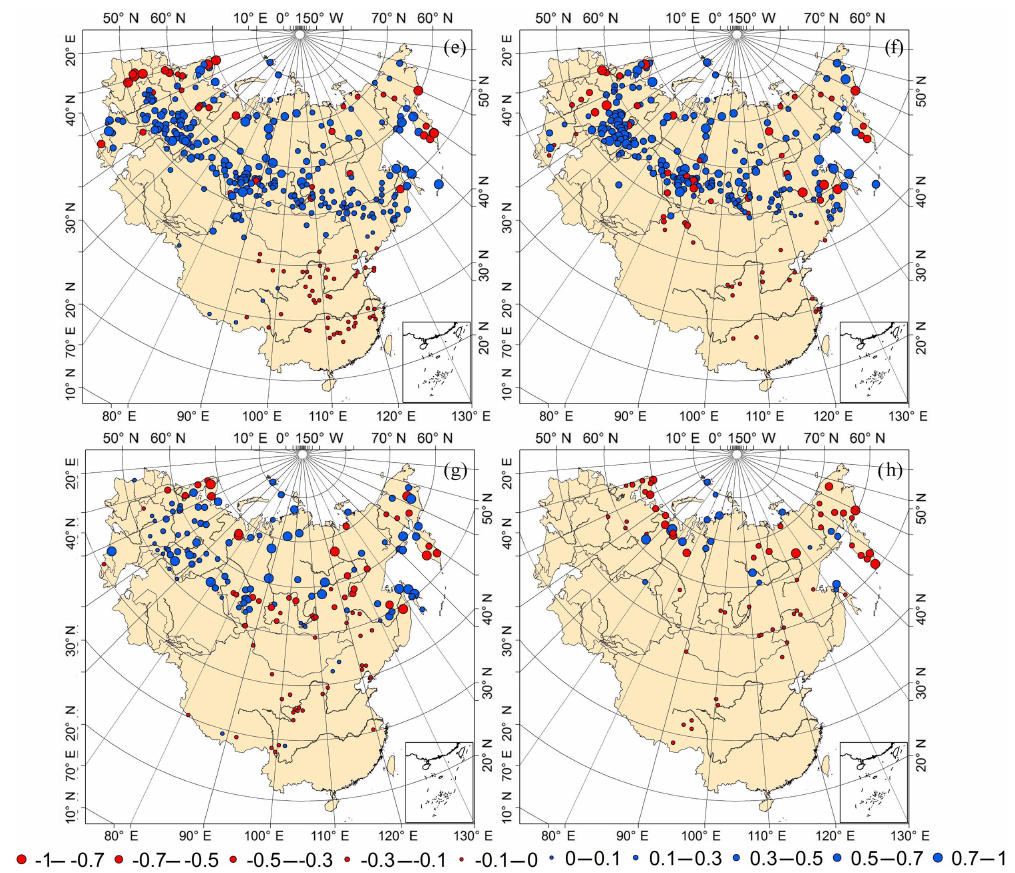
Figure 7. Spatial distributions of linear trend coefficients (cmyr − 1 ) of monthly mean snow depth (from October to May) during 1966 to 2012. (a) October. (b) November. (c) December. (d) January. (e) February. (f) March. (g) April. (h) May. The rate of change at the 95% level is displayed. Red circles represent a decreasing trend, and blue circles represent an increasing